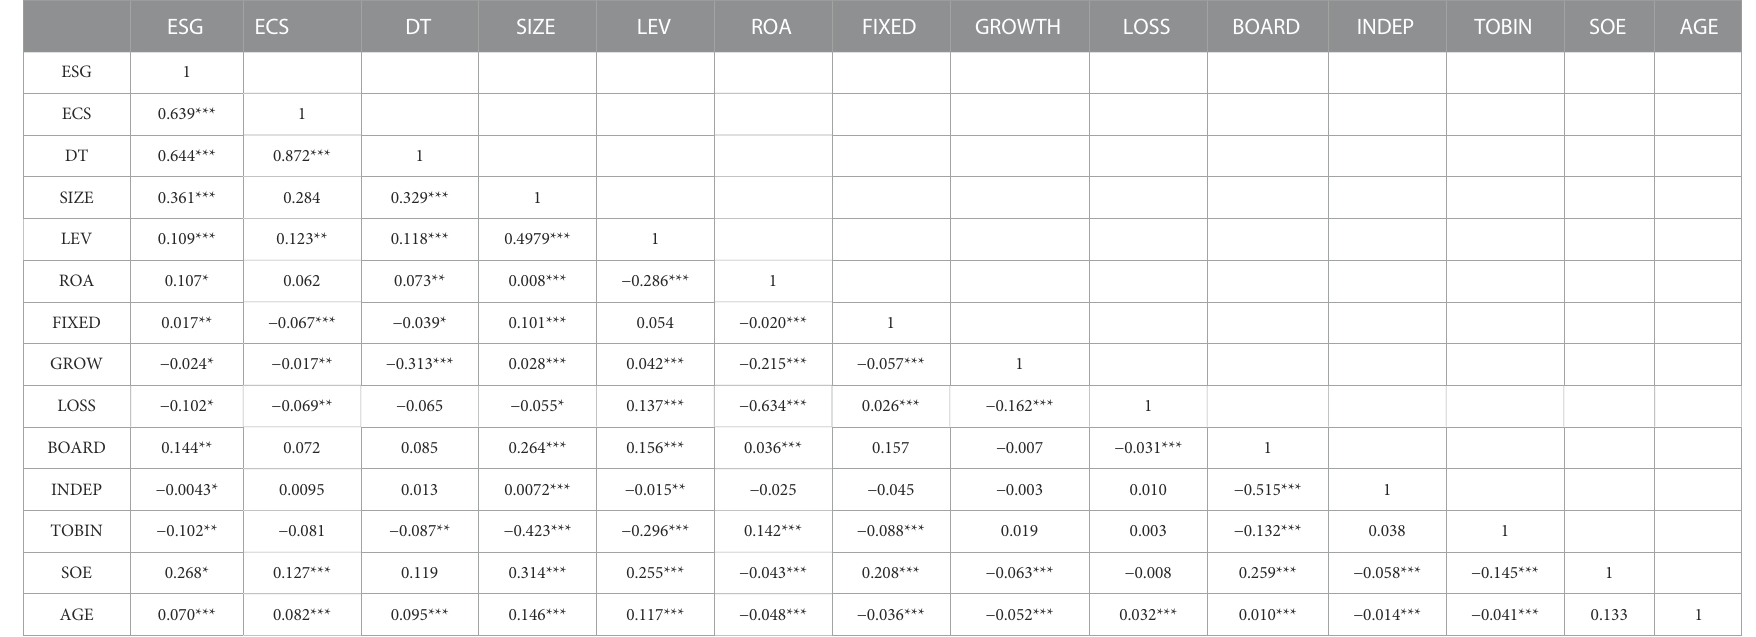
TABLE 3 Correlation